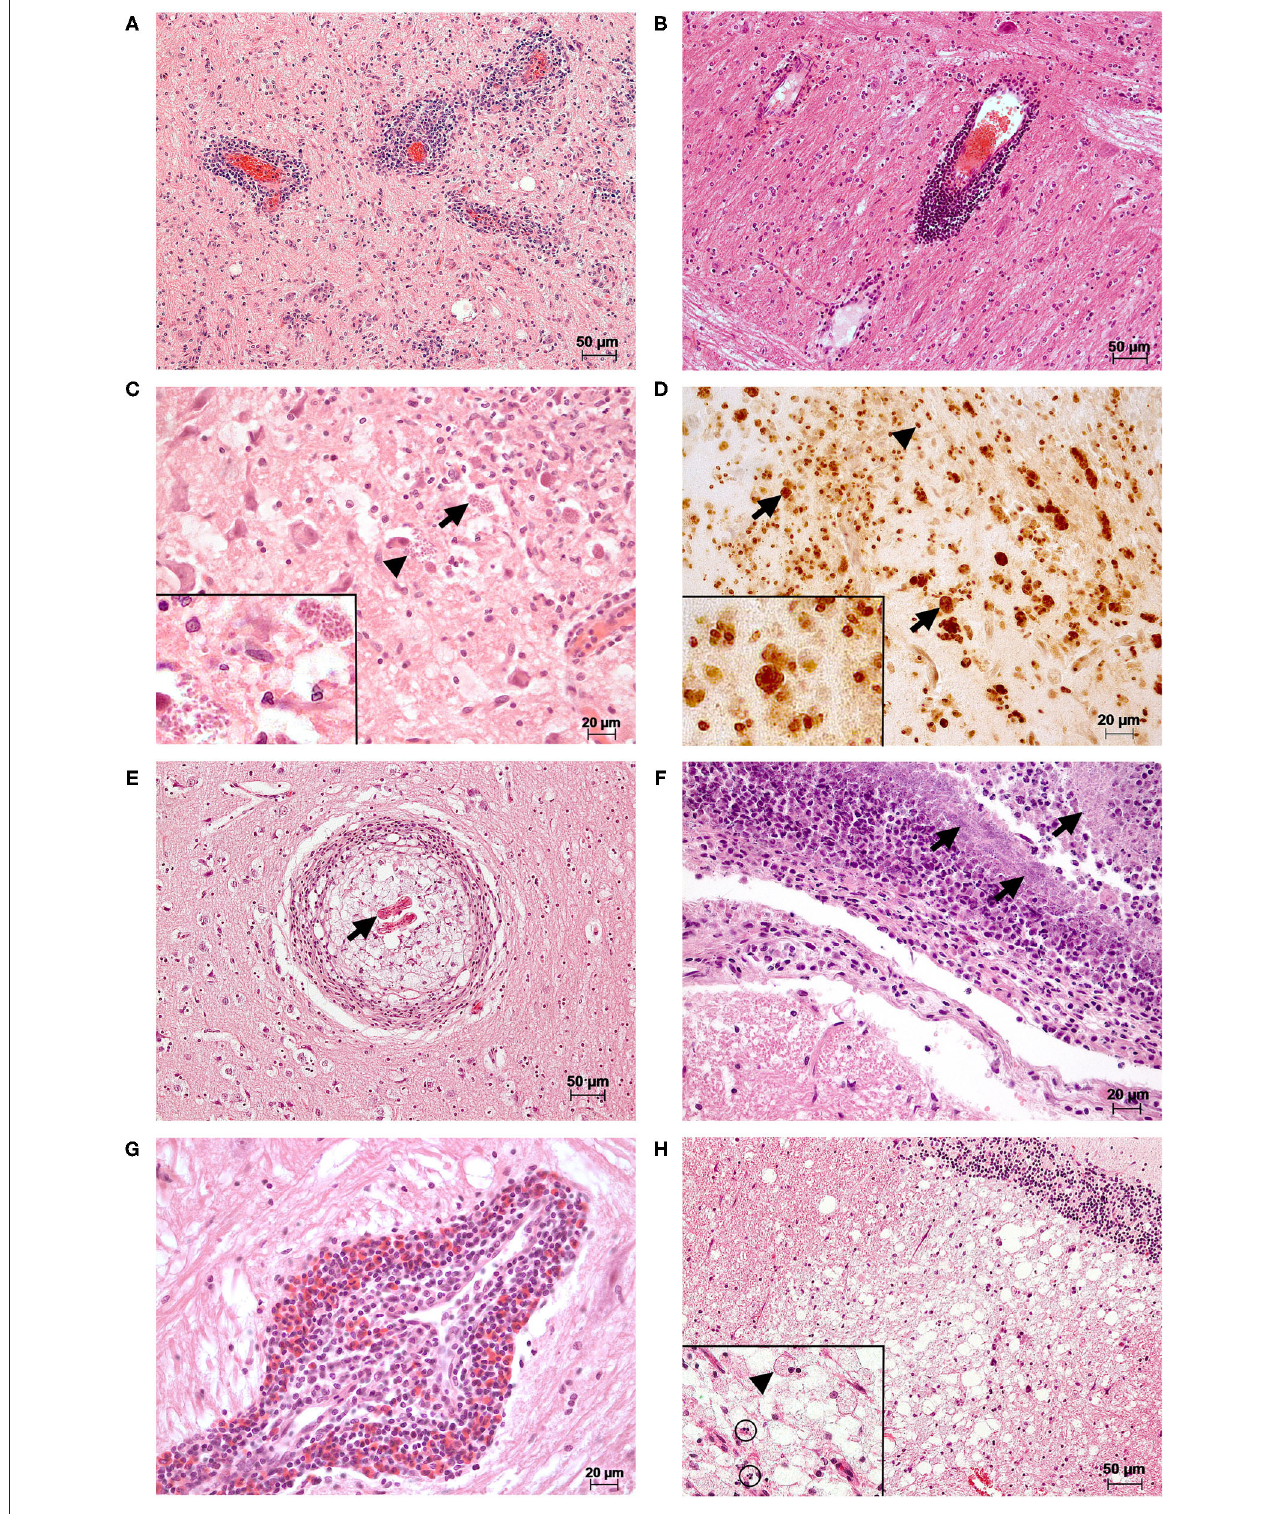
FIGURE 2 | Histopathological changes observed in the brains of selected cases. (A) A marked multifocal, mainly perivascular lymphoplasmacellular meningoencephalitis was present in the brain stem of a female adult red fox with detection of CDV (RT-qPCR; Lab-ID: 17410254906). Changes were observed in all examined localizations of the brain (meninges not shown). HE (B) There is a marked multifocal perivascular lymphocytic encephalitis in the brain stem of a male adult